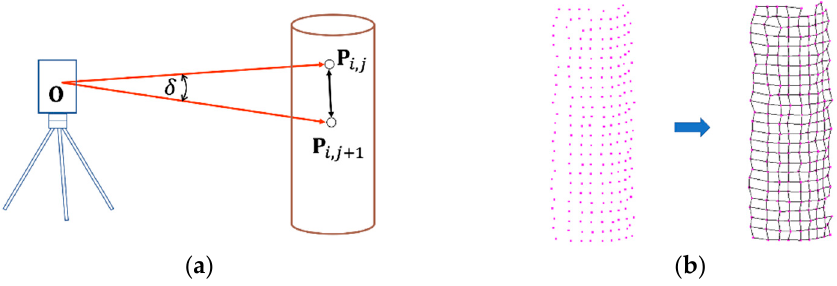
Figure 6. Generating a wireframe model. ( a ) Estimation of the distance between neighbor points; ( b ) edges between neighboring points (a wireframe model).